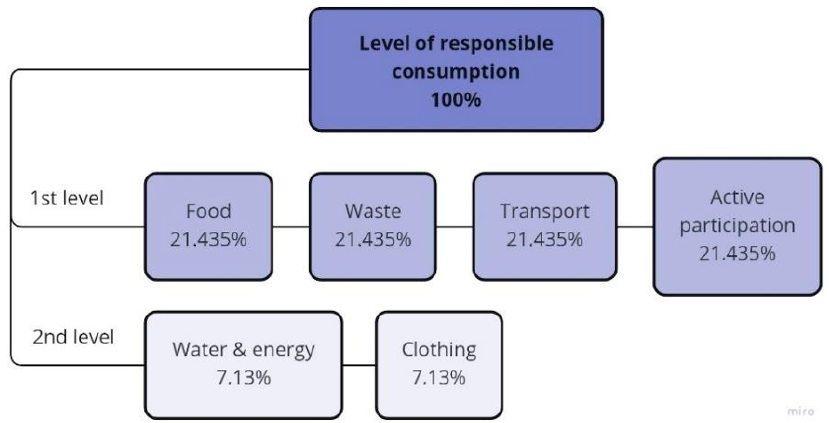
Figure 7. Individual indicator weights calculated according to Fishburne’s law.